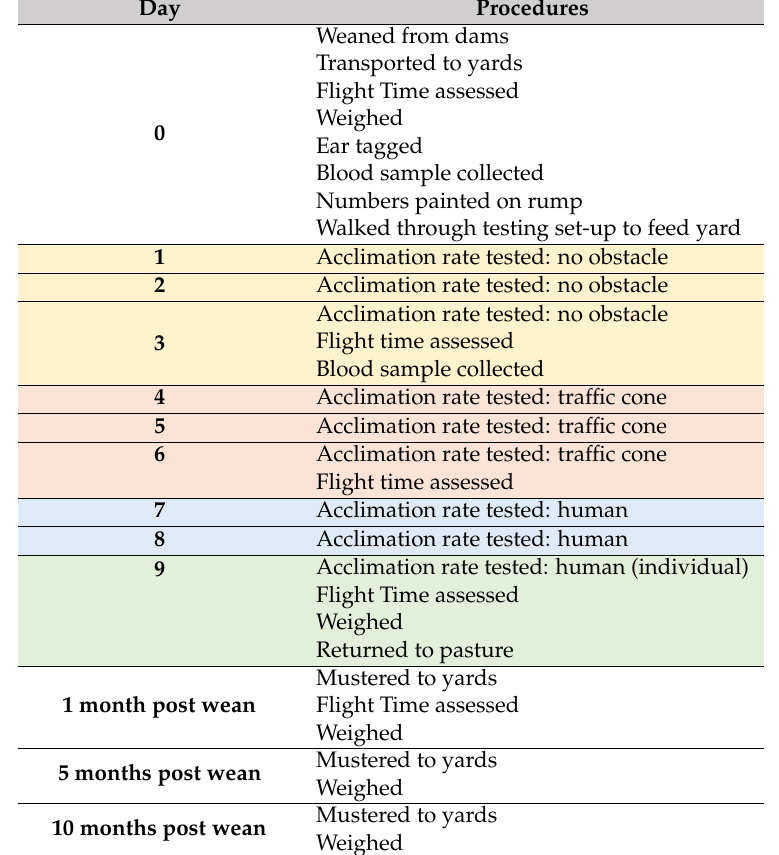
Table 1. Timeline for the acclimation trial indicating when each procedure was performed on the heifers. Procedures are listed in chronological order for each given day of the trial. The different phases of acclimation rate testing are indicated by different colours (phase 1—yellow, 2—orange, 3—blue,